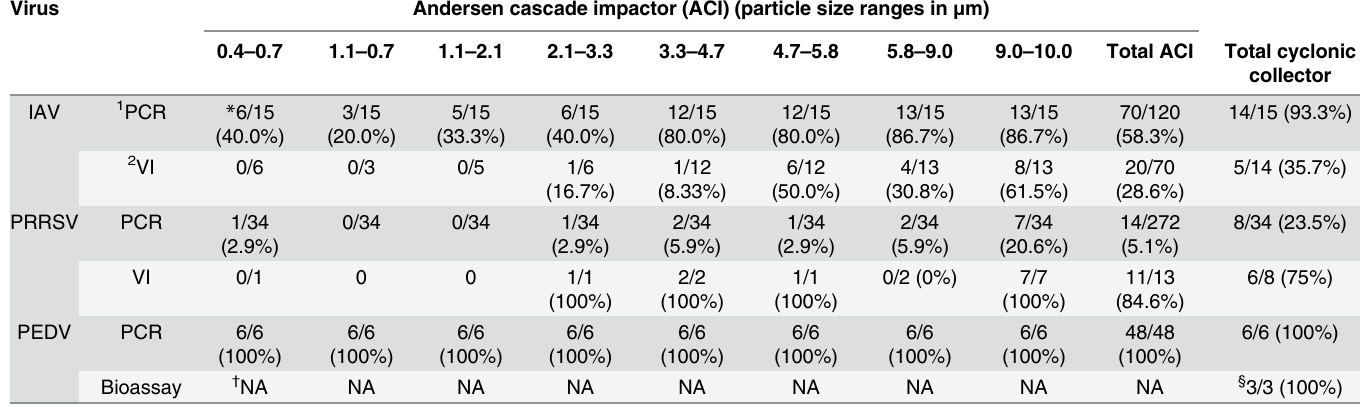
Table 2. RT-PCR and virus isolation results by particle size and air sampler type. Number of positive RT-PCR and virus isolation (VI) air samples for influenza (IAV), porcine reproductive and respiratory syndrome (PRRSV) and bioassay for porcine epidemic diarrhea (PEDV) viruses collected from acutely infected animals. Results are presented by air sampler, and in the case of the Andersen cascade impactor, by particle size rage.